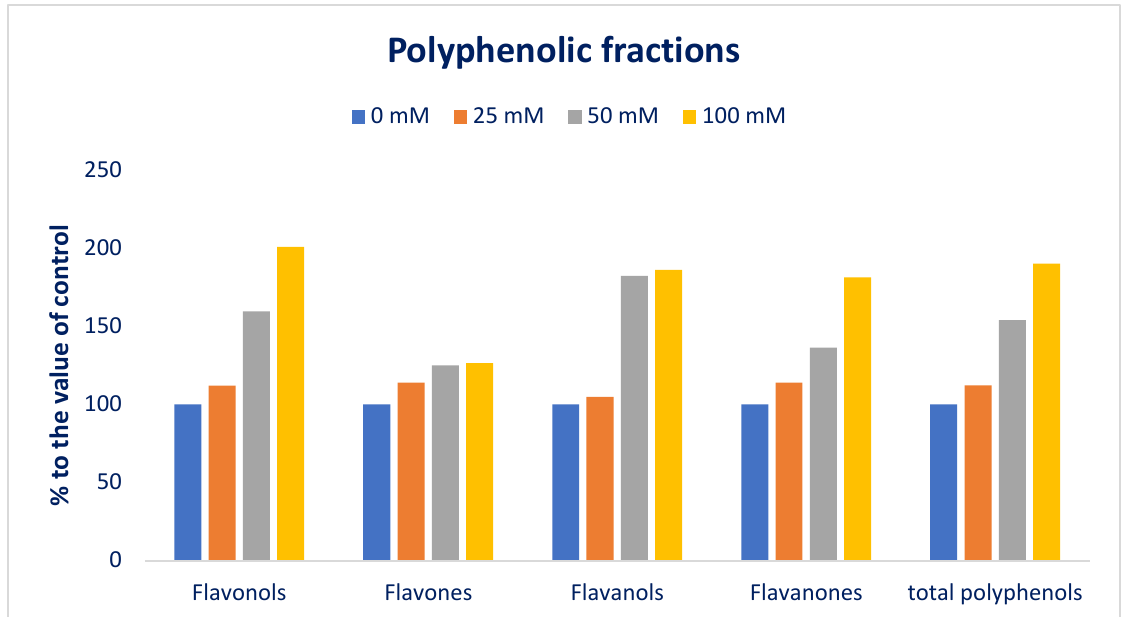
Figure 12. Comparison of the salt-induced increment polyphenolic fractions (%) over control in